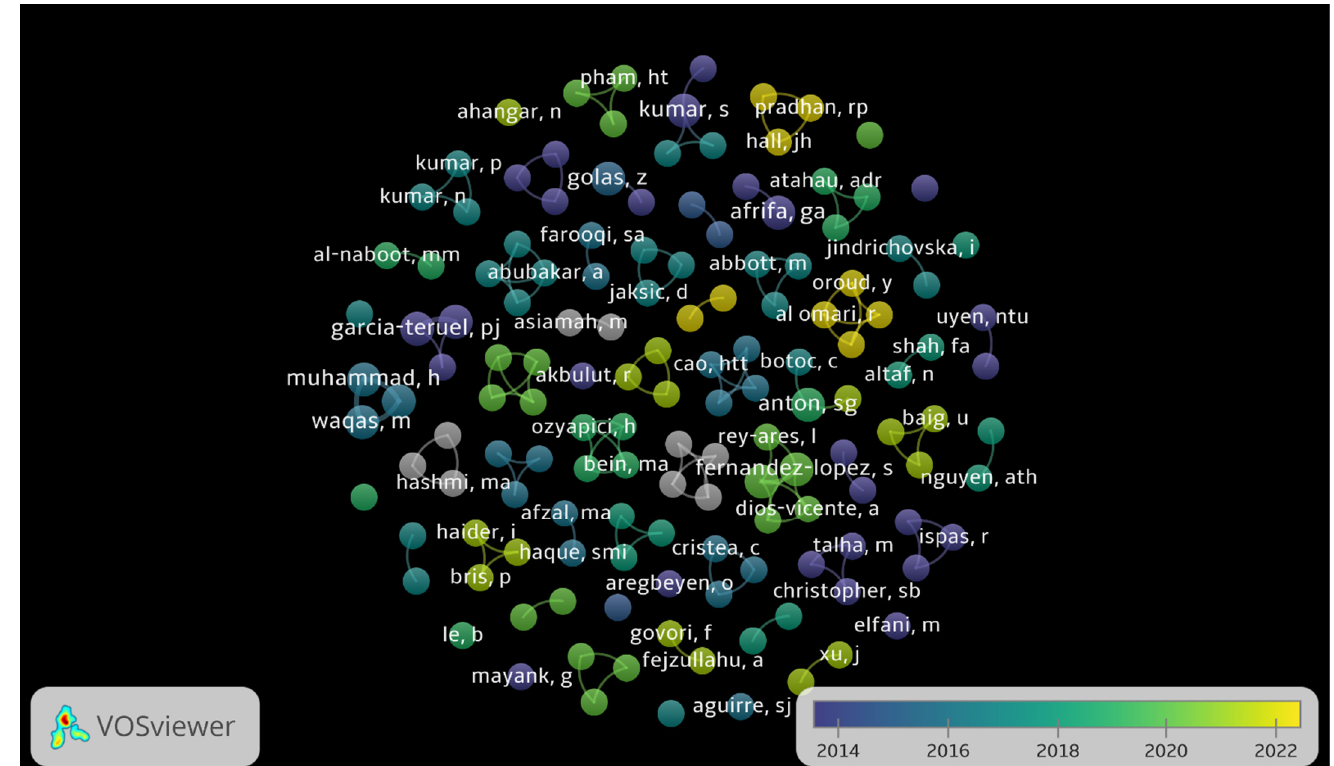
Figure 1. Bibliographic analysis I.